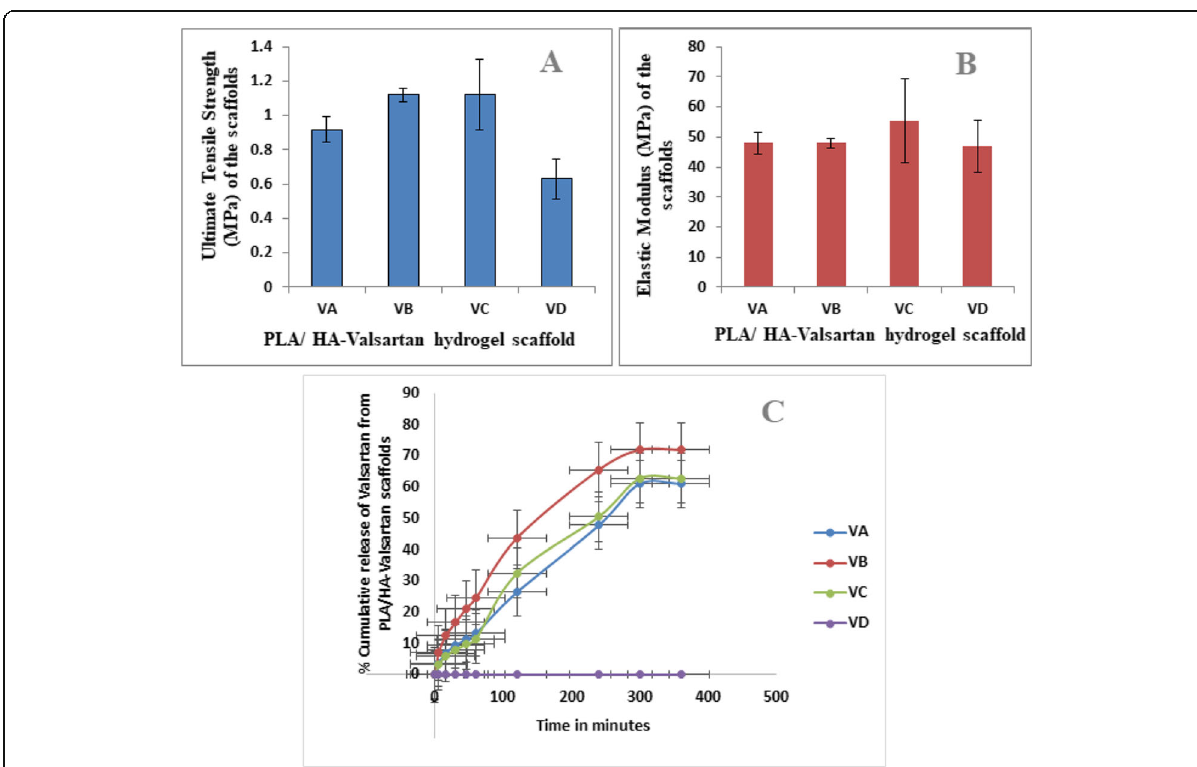
Fig. 4 a Ultimate tensile strength. b Elastic modulus. c Cumulative release of valsartan from PLA/HA-valsartan scaffolds VA, VB, VC, and